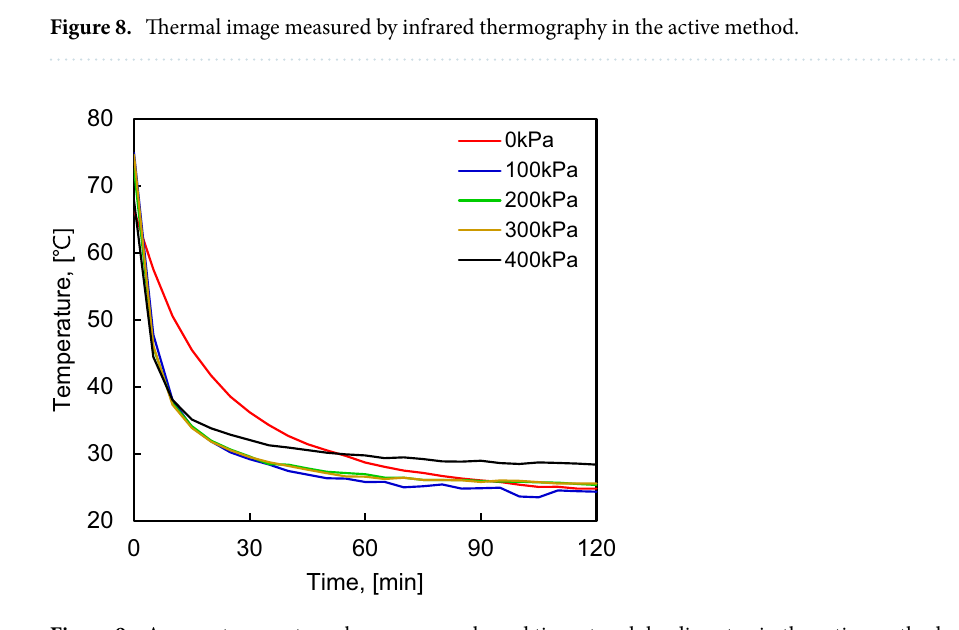
Figure 9. Average temperature change versus elapsed time at each loading step in the active